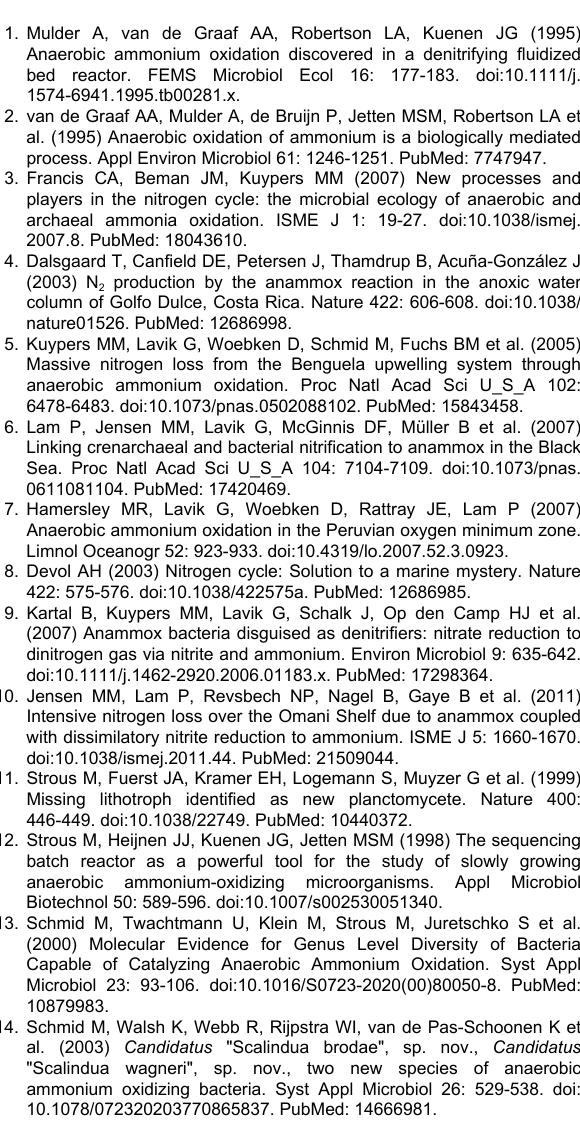
Figure S3. Neighbor-joining phylogenetic tree constructed with anammox bacteria 16S rRNA gene sequences from the oxygen minimum zone (OMZ) in Costa Rica Dome (CRD).